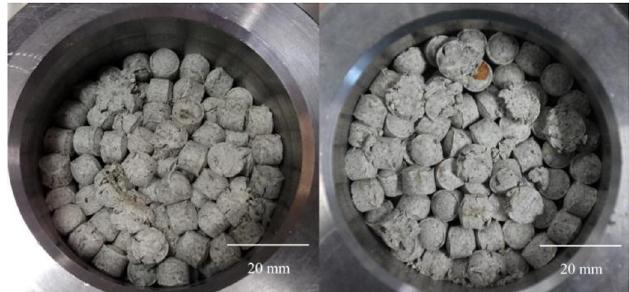
Table 4. Parameters used in the DEM simulations of swelling pressure tests.